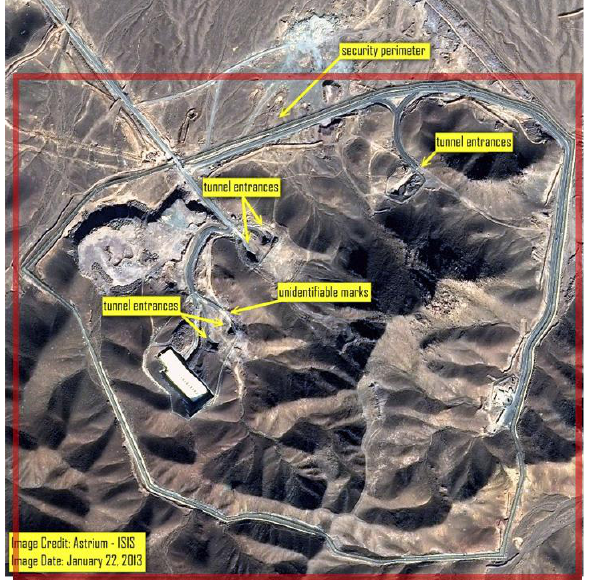
Figure 3. Red line marks the extent of the “after”